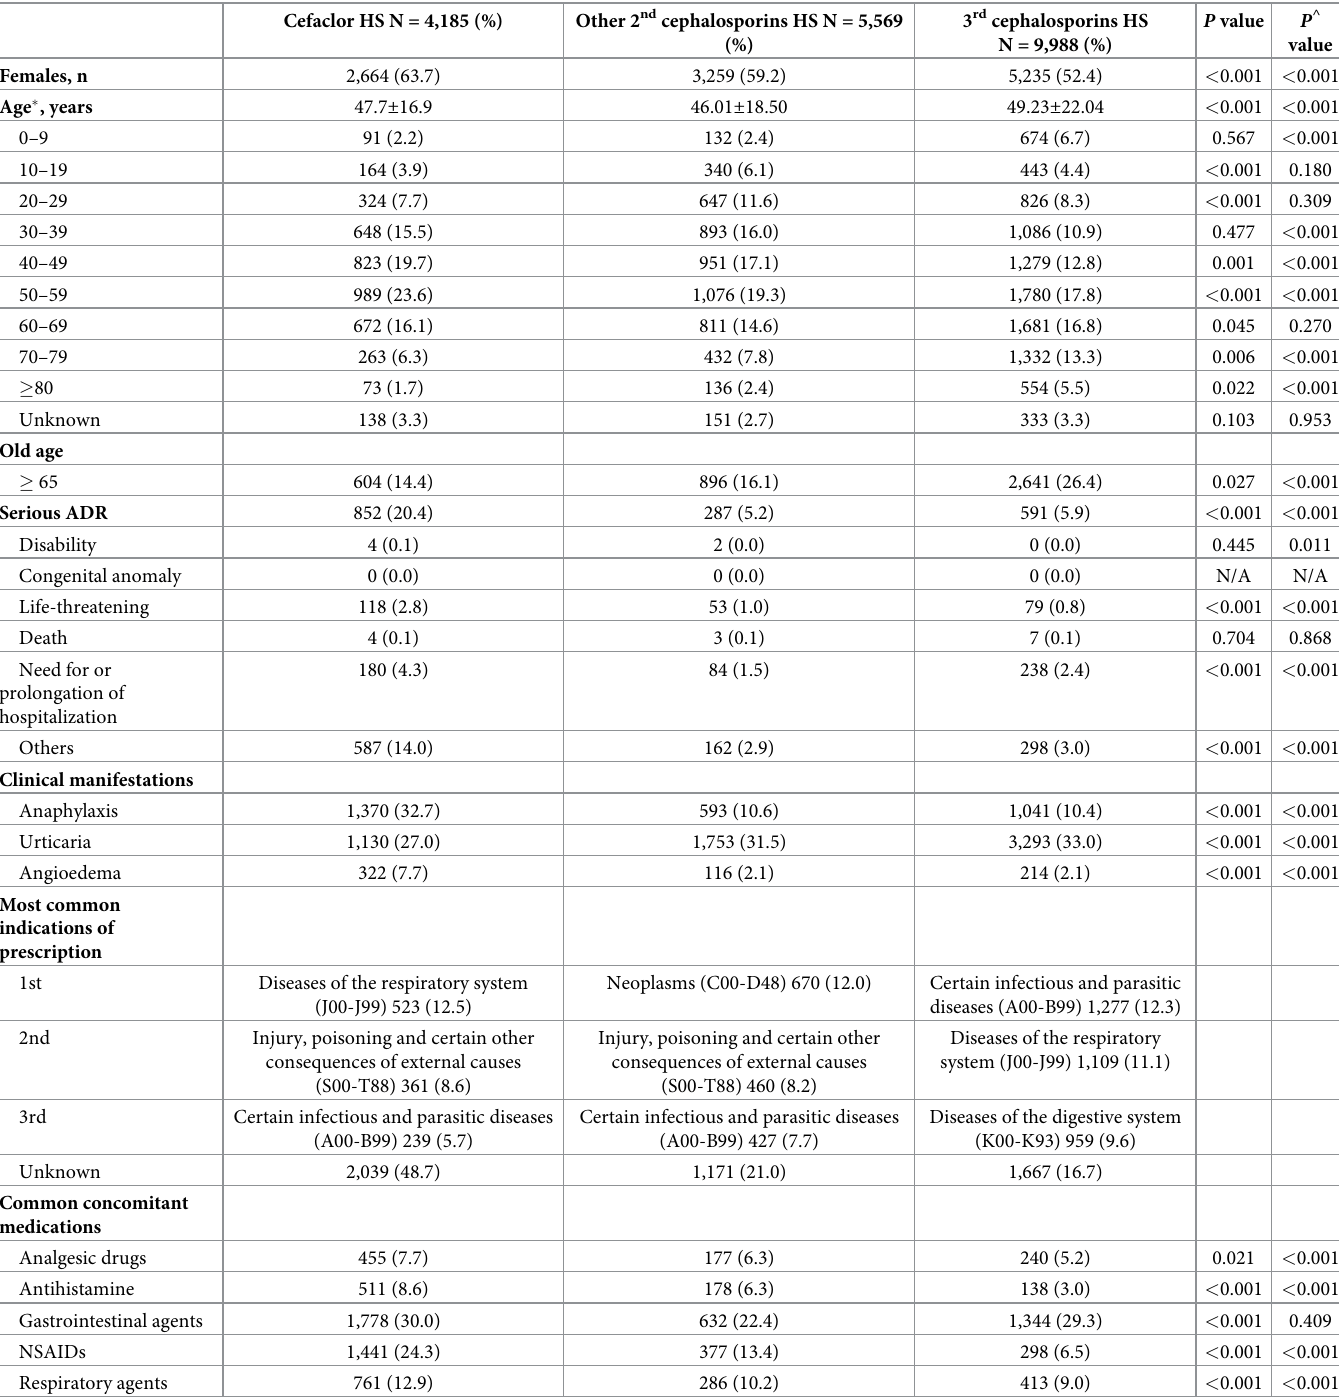
Table 4. Assessment and clinical characteristics of hypersensitivity to cefaclor and other 2 nd and 3 rd